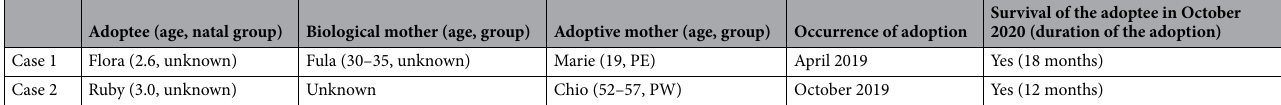
Table 1. The information of adoptees, biological and adoptive mothers, and duration of